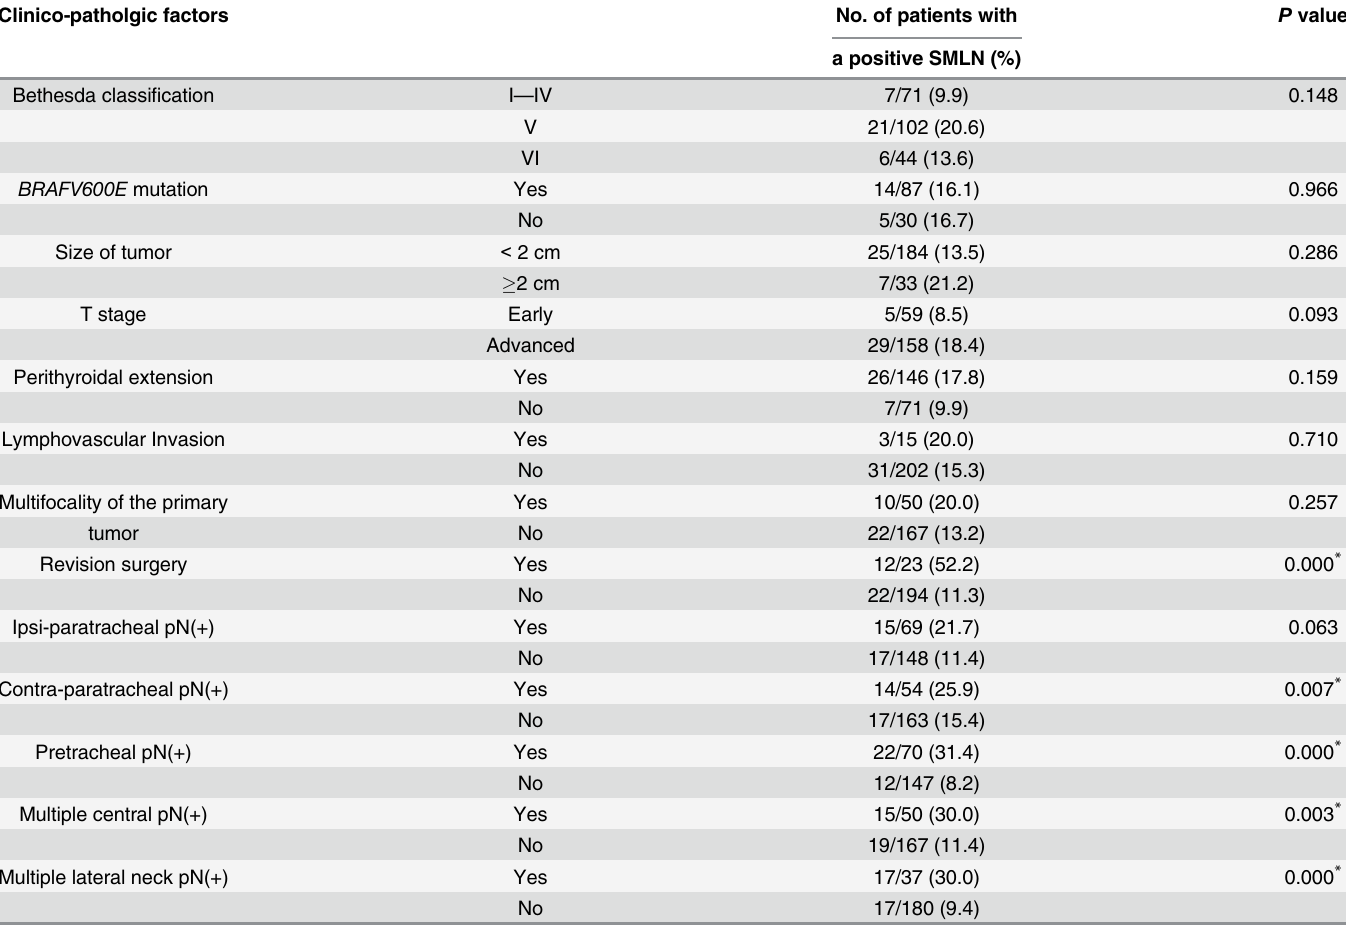
Table 3. Clinico-pathologic factors related to SMLN metastasis in 217 papillary thyroid carcinoma patients: univariate analysis. Ipsi; ipsilateral, Contra; contralateral, SMLN: superior mediastinal lymph node, Small tumor: (cid:1) 2 cm, large tumor: > 2 cm, Early T stage: TI and TII, Advanced T stage: TIII and TIV, PTE: perithyroidal extension excluding microscopic